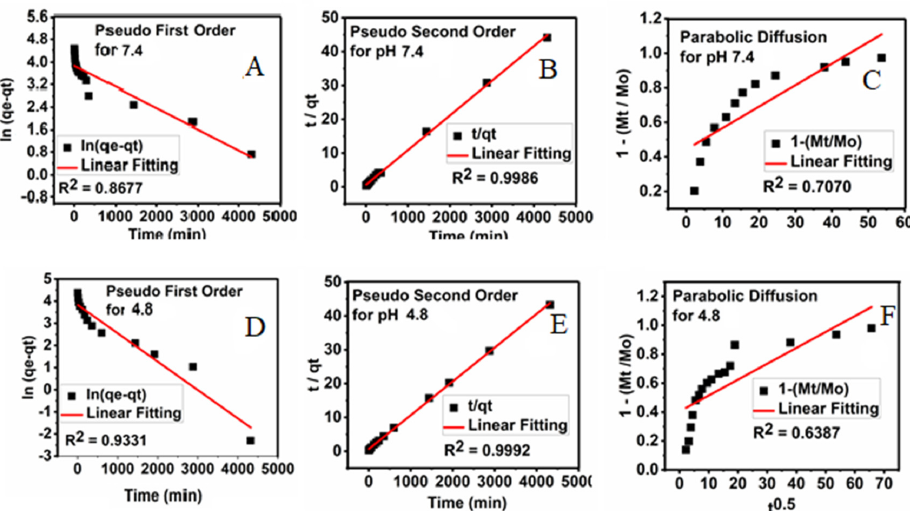
Figure 12. Fitting the data of sorafenib release from its M-PEG–SO–ZLDH nanoparticles into phosphate-buffered saline (PBS) solution to ( A ) the pseudo-first-order kinetic; ( B ) the pseudo-second-order kinetic; ( C ) the parabolic diffusion for pH 7.4; ( D ) the pseudo-first-order kinetic; ( E ) the pseudo-second-order kinetic; ( F ) the parabolic diffusion for pH 4.8. Abbreviations: t, time; q t , release at time t.